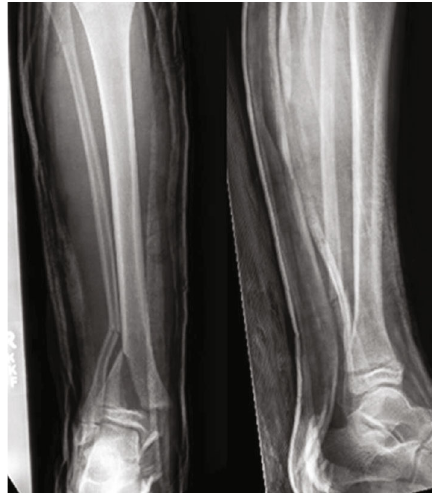
Figure 2: Anteroposterior and lateral radiographs of the ankle following attempt of closed redcution.